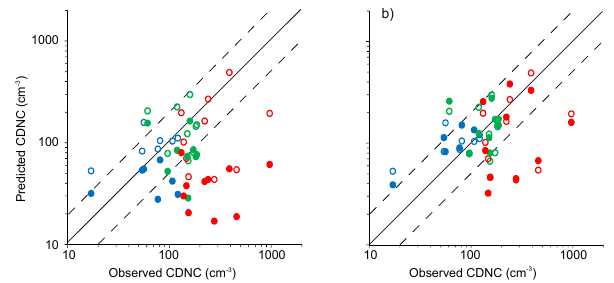
Figure 3. Comparison of CESM/CAM5-predicted (at ∼ 930mb) and observed low-level CDNC from field campaigns in clean ma- rine (blue), polluted marine (green), and continental (red) environ- ments as classified and summarized by Karydis et al. (2011). The filled circles are for the (a) AR-G00 and (b) FN05 simulations and hollow circles for the FN05/K09/B10 simulation. Data points where predicted CDNC < 10cm − 3 were not included. The 1:1 and 1:2/2:1 lines are the solid and dotted black lines,